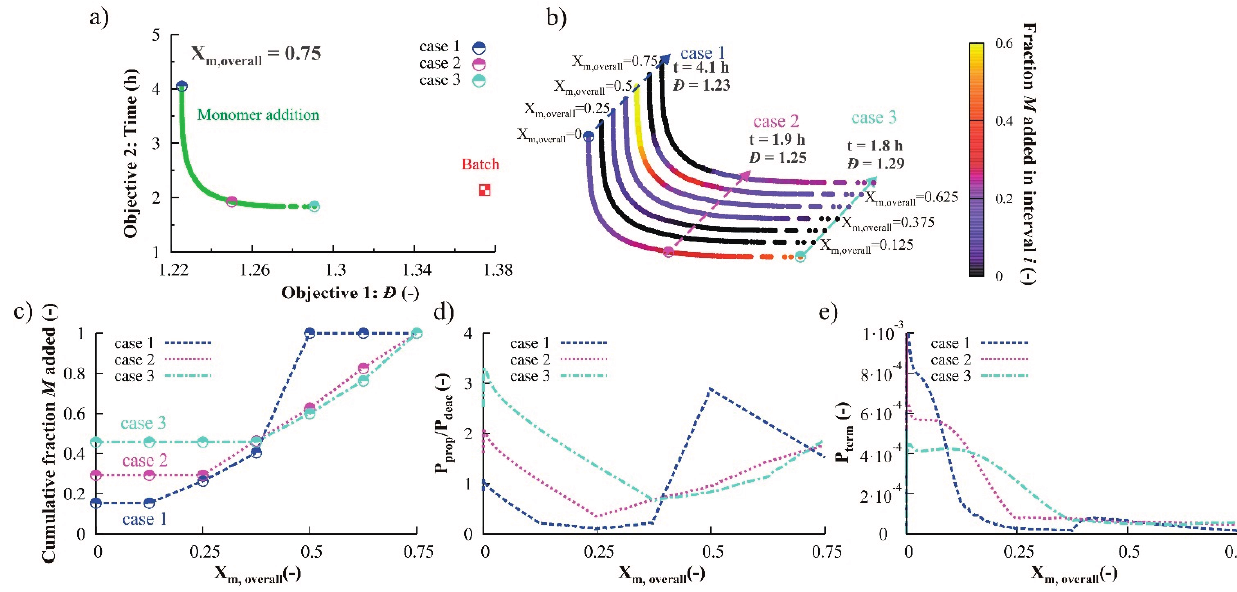
Figure 3. Results for the multi-objective optimization (MOO) of ARGET ATRP of BMA using a fed-batch monomer program (constant molar flow rate per Δ X m, overall of 0.125 until X m, overall = 0.75; 90 °C; [ R 0 X ] 0 /[ Cu II X 2/ L ] 0 /[ Sn II (EH) 2 ] 0 = 1/0.005/0.05; batch case: [ M ] 0 /[ R 0 X ] 0 = 200). ( a ) Pareto-optimal front (green circles) and reference batch polymerization (red square); ( b ) Variation of the seven variables (fraction monomer added initially (variable 1) and during a conversion interval (variable 2–7) along the Pareto-optimal front; ( c ) Cumulative fraction of monomer added as a function of X m, overall for three selected cases in (a); ( d ) Ratio of probability for propagation over deactivation as a function of X m, overall for the selected cases; ( e ) Probability for termination as a function of X m, overall for the selected